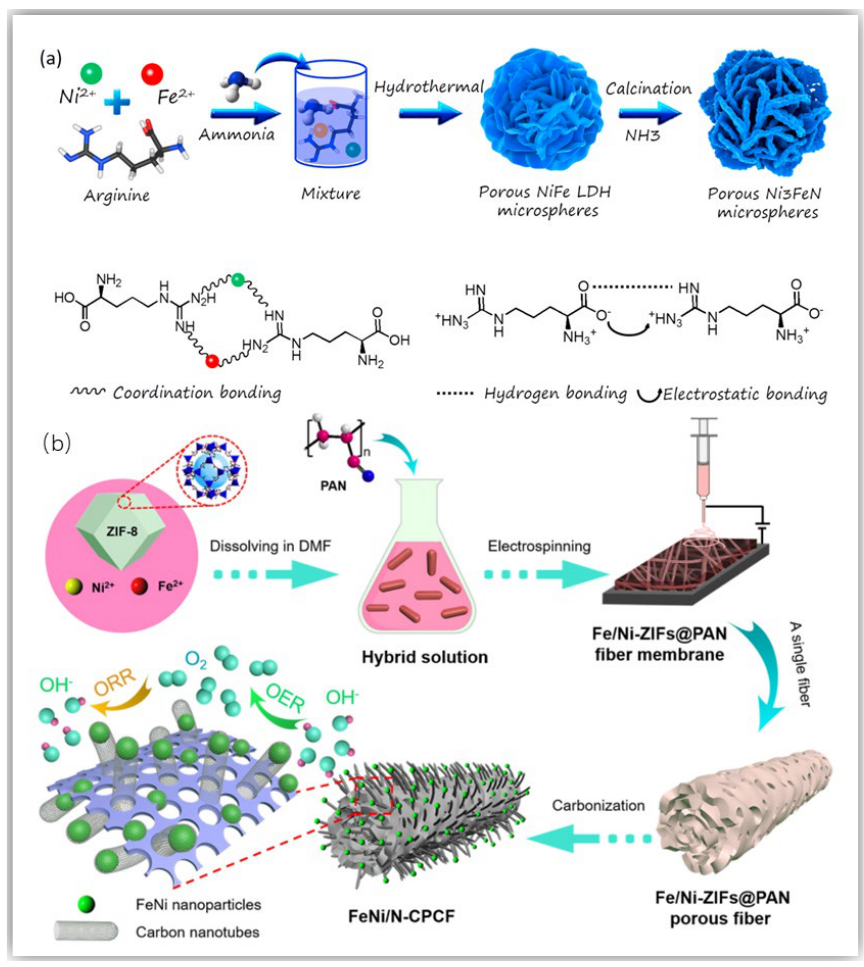
Figure 5. (a) Schematic illustration of the formation of the porous Ni 3 FeN hierarchical microspheres, the interaction between arginine and metal ions, and the interaction between arginine